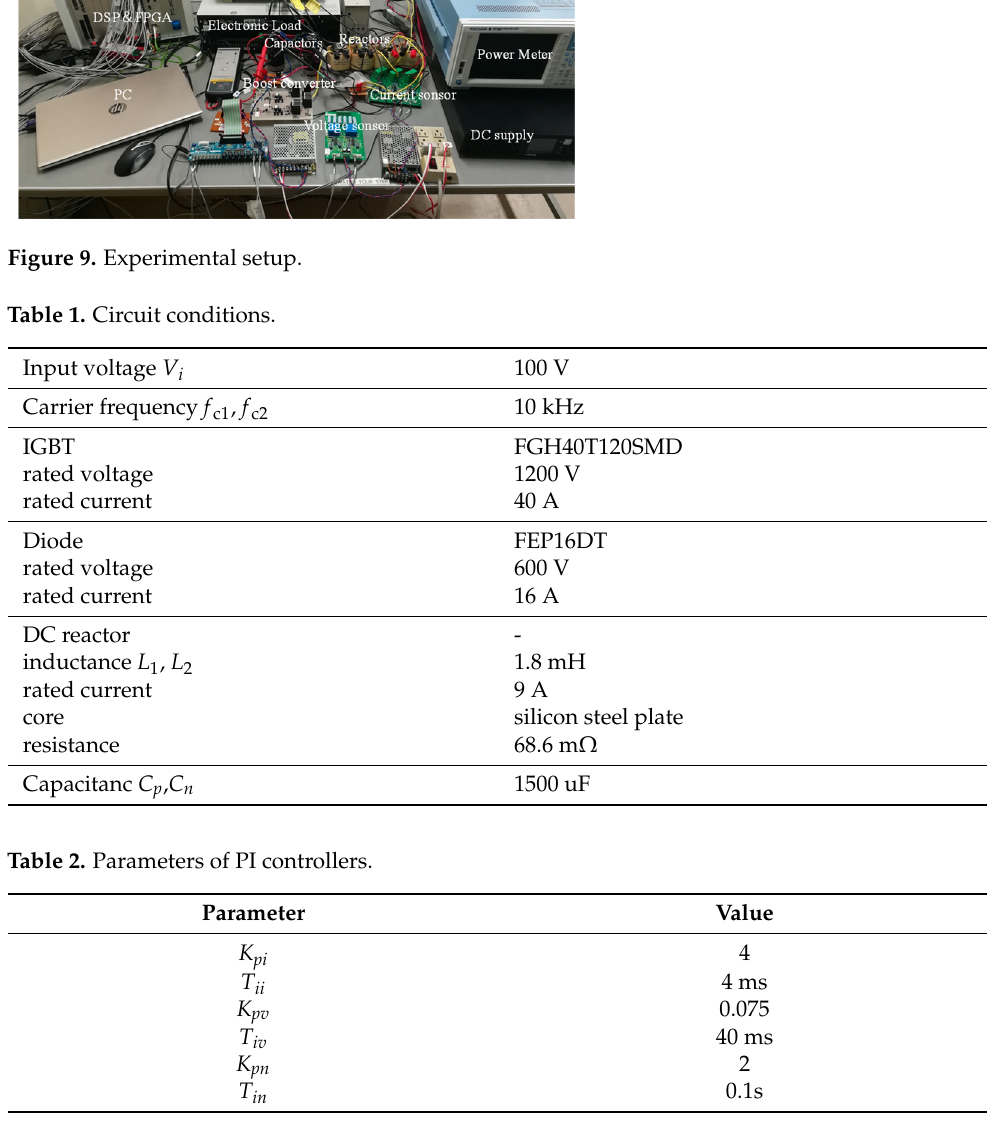
1500 uF Table 2. Parameters of PI controllers. Parameter